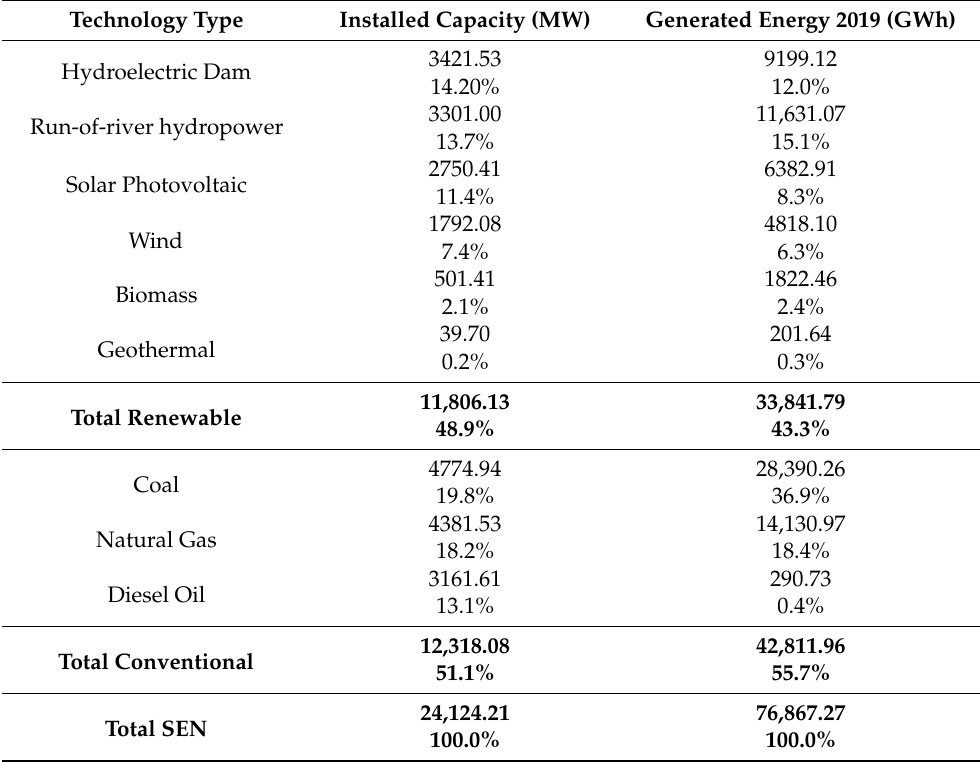
Table 1. Detail of installed capacity and electricity generation for the year 2019 in the National Electrical System (SEN). Percentages in parentheses